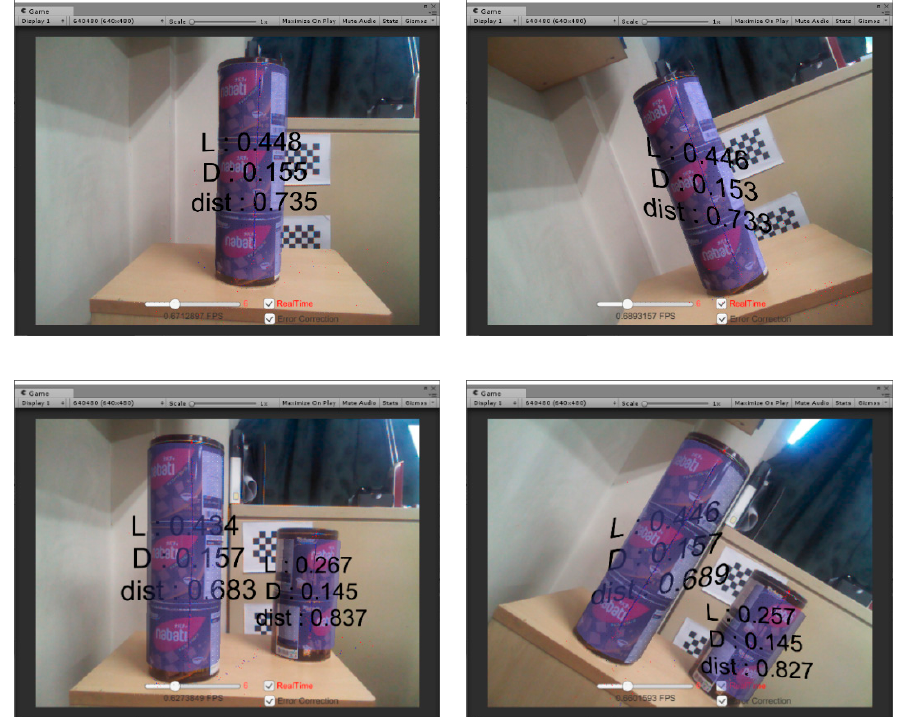
Figure 17. Phase-shift sensor real-time matching results for six cores and six frames; FOV = 48.6°; 𝛜 = 50 error correction mode (m).